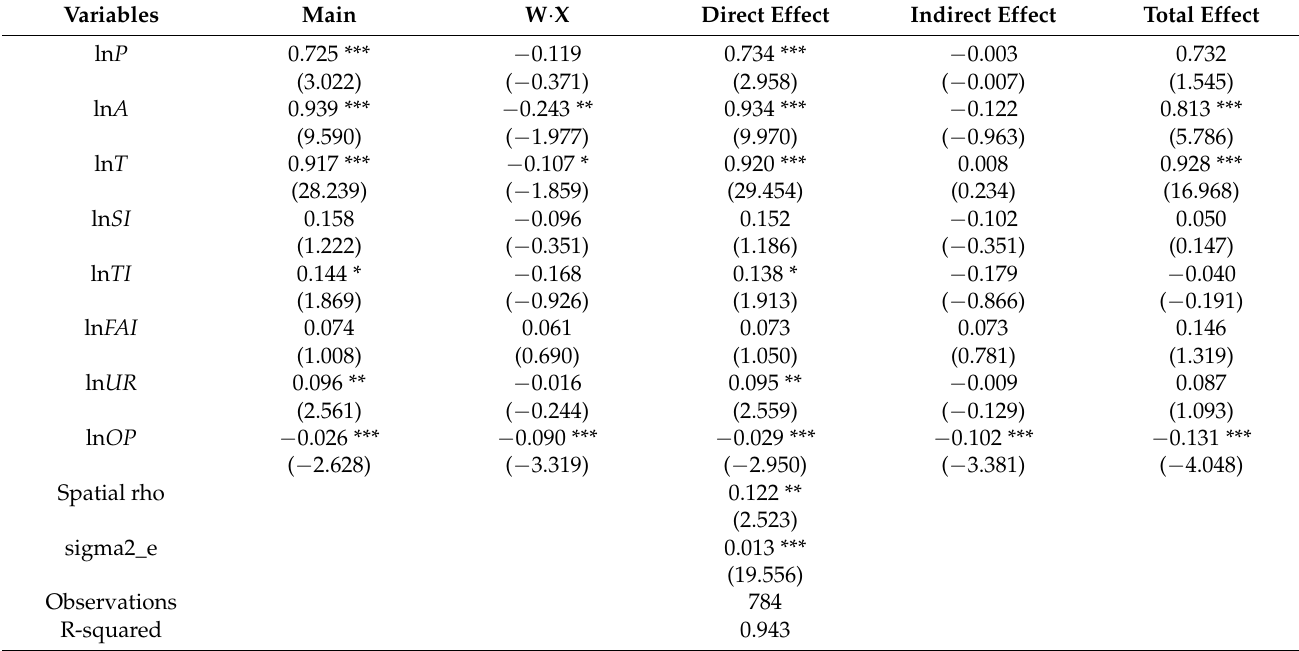
Table 4. Estimation results based on the